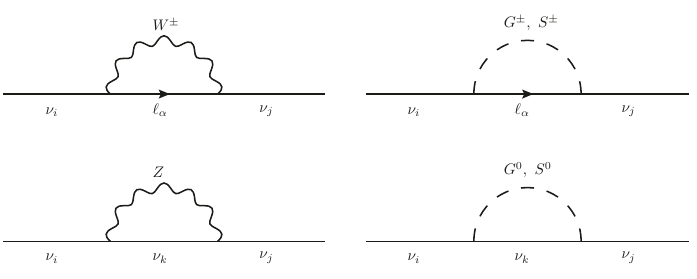
Figure 3 . Self-energy Feynman diagrams contributing to the radiative corrections to the neutrino